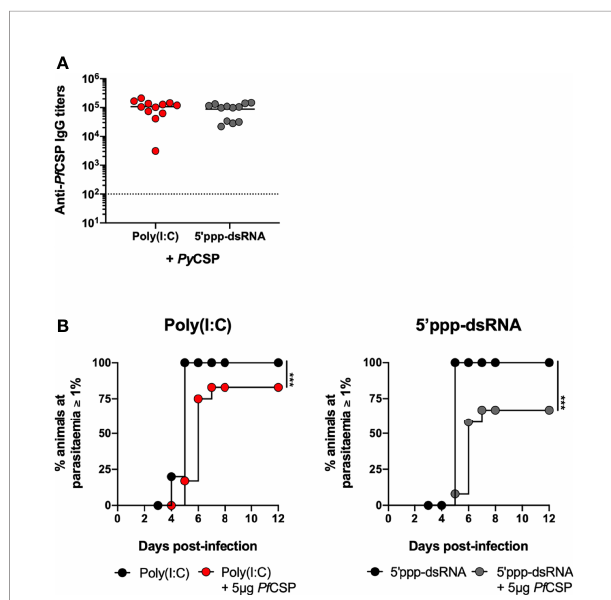
FIGURE 6 | Short-term protection conferred by immunization with Pf CSP in combination with RLRs adjuvants. (A, B) Short-term protection to a skin challenge in control mice (n = 12) and mice immunized with Pf CSP in combination with poly(I:C) (n = 12, three independent experiments) or 5 ’ ppp-dsRNA (n = 12, three independent experiments), 2 weeks post booster immunization. (A) Total anti -Pf CSP IgG titers in the sera of immunized mice. Symbols represent individual values and black lines the mean of each group. Dotted line represents the minimal detectable titer. (B) Incidence of blood stage infection after a skin challenge with 5,000 Pf CSP/ Py sporozoites in control and immunized mice. Statistical signi fi cance was determined with unpaired two-tailed t -test (A) . Survival curves were plotted using Kaplan- Meier plot and statistical signi fi cance was determined using the Log-Rank (Mantel- Cox) test (B) . ***p ≤